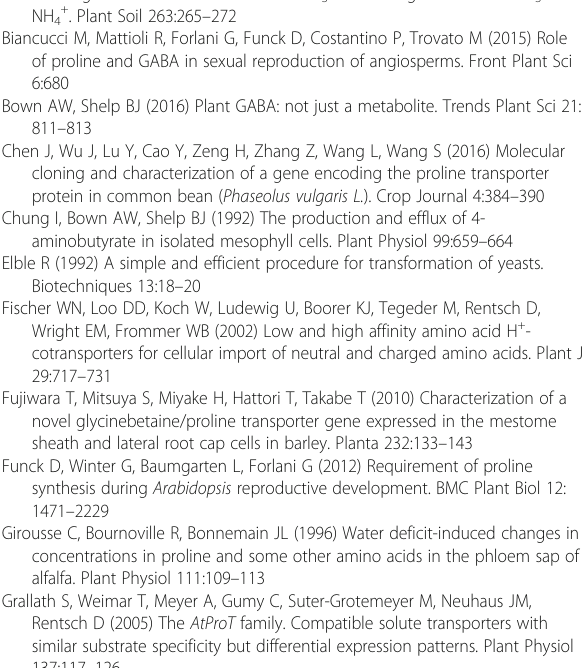
Additional file 1: Figure S1. Alignment of OsProT proteins. Figure S2. Expression levels of OsProT2 in different organs at vegetative and reproductive stages. Figure S3. OsProT2 transcript levels in rice plants under different abiotic stress conditions. Table S1. The primers used in this